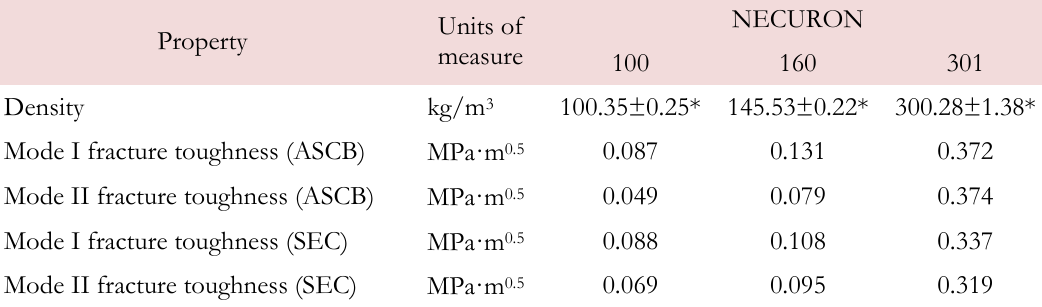
Table 6: Material properties determined experimentally (* standard deviation values).